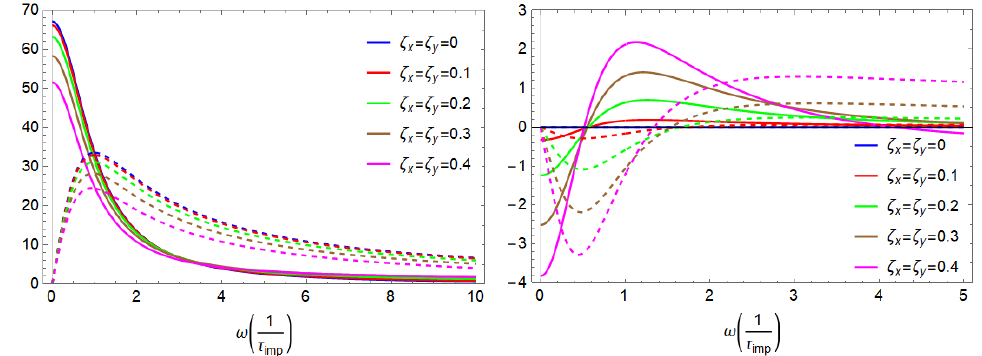
Figure 6: (Left) Real part (solid-lines) and imaginary part (dashed-lines) of σ xx for viscous fluid of TDFs at T = 150 K in units of [ meV. τ inside the broad Drude peak can be revealed by polar dependence in Figs. 1 and 4- Left. (Right) The same for σ x y